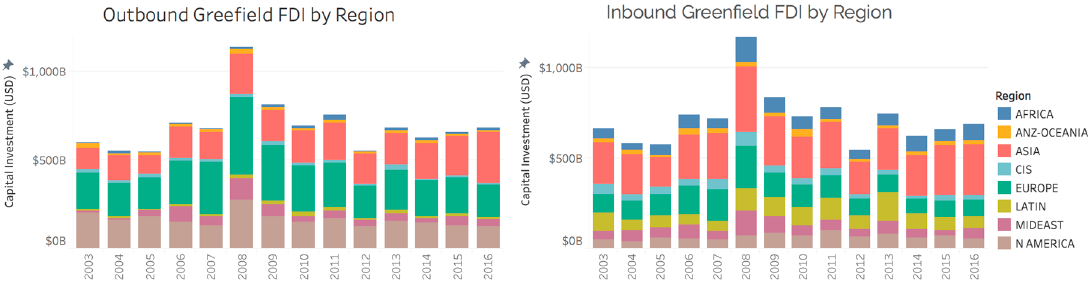
Figure 3. Inbound and outbound Greenfield (GF) FDI (2003–2016). Asian FDI patterns are compared with Europe and North America.